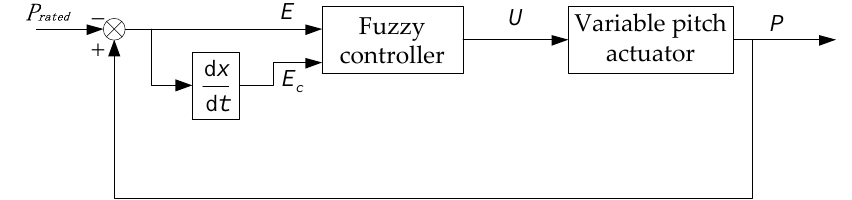
Figure 3. Schematic diagram of the fuzzy variable pitch controller.